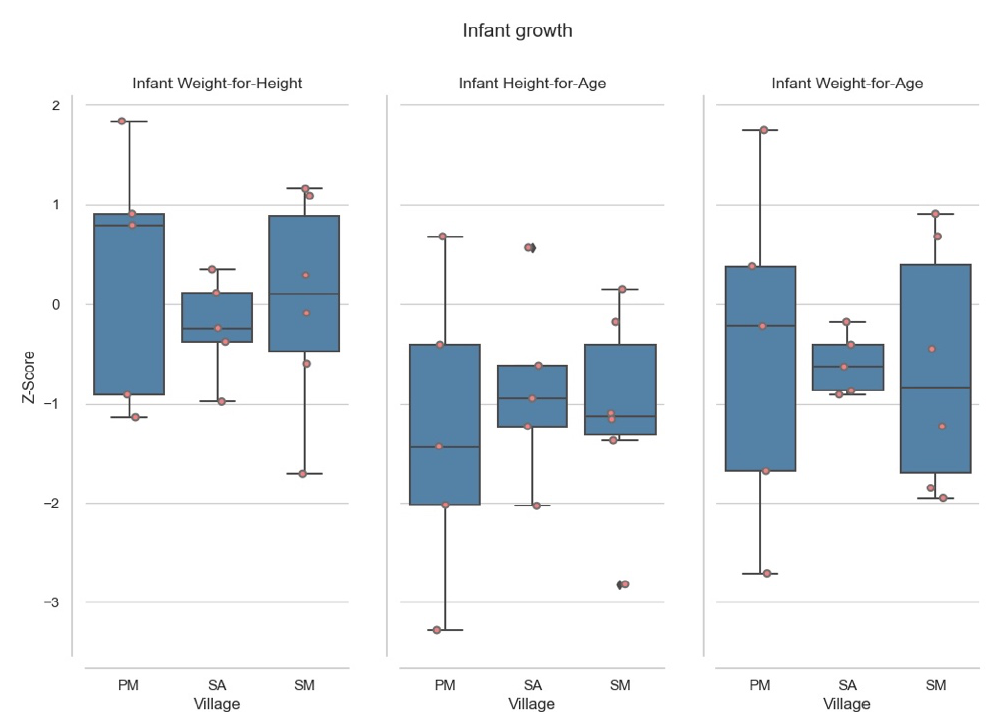
Figure 1. Infant Z Scores for measures of growth. PM corresponds to Poxo Muybu village; SA is Sawré Aboy and SM is Sawré Muybu . S.D. < − 3 is severely deficient (severely wasted/stunted/underweight); S.D. < − 3 and < − 2 correspond to deficient (wasted/stunted/underweight); zero is normal; >2 is weight-for-height is overweight, Sawré Muybu Indigenous Land, Brazilian Amazon, 2019.